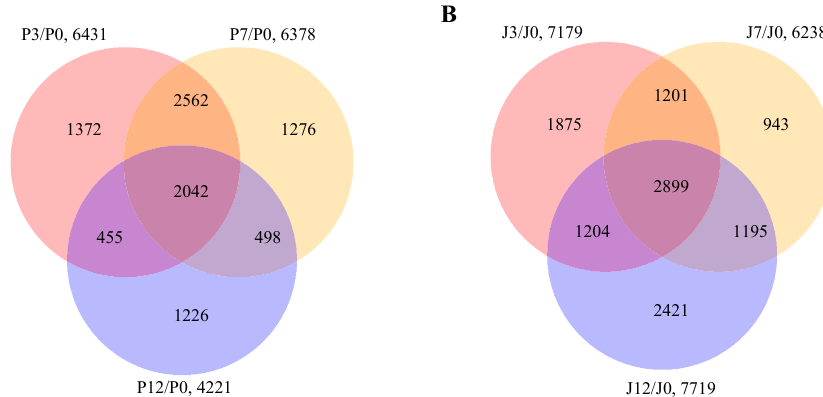
Figure 1. Venn diagrams depicting the number of differentially expressed genes (DEGs) during the graft process. ( A ) Number of DEGs in ‘Pawnee’. ( B ) Number of DEGs in ‘Jinhua’. P3/P0, P7/P0, and P12/P0 represent the DEGs of ‘Pawnee’ at 3, 7, and 12 days after grafting (DAG), respectively. J3/J0, J7/J0, and J12/J0 represent the DEGs of ‘Jinhua’ at 3, 7, and 12 DAG, respectively. A suitable soft threshold power ( β ) is the first step for building a co-expression net- work. Our results showed that as the β value increased, the scale-free topology fit index (R 2 ) progressively increased, while the mean connectivity sharply decreased (Figure 2).